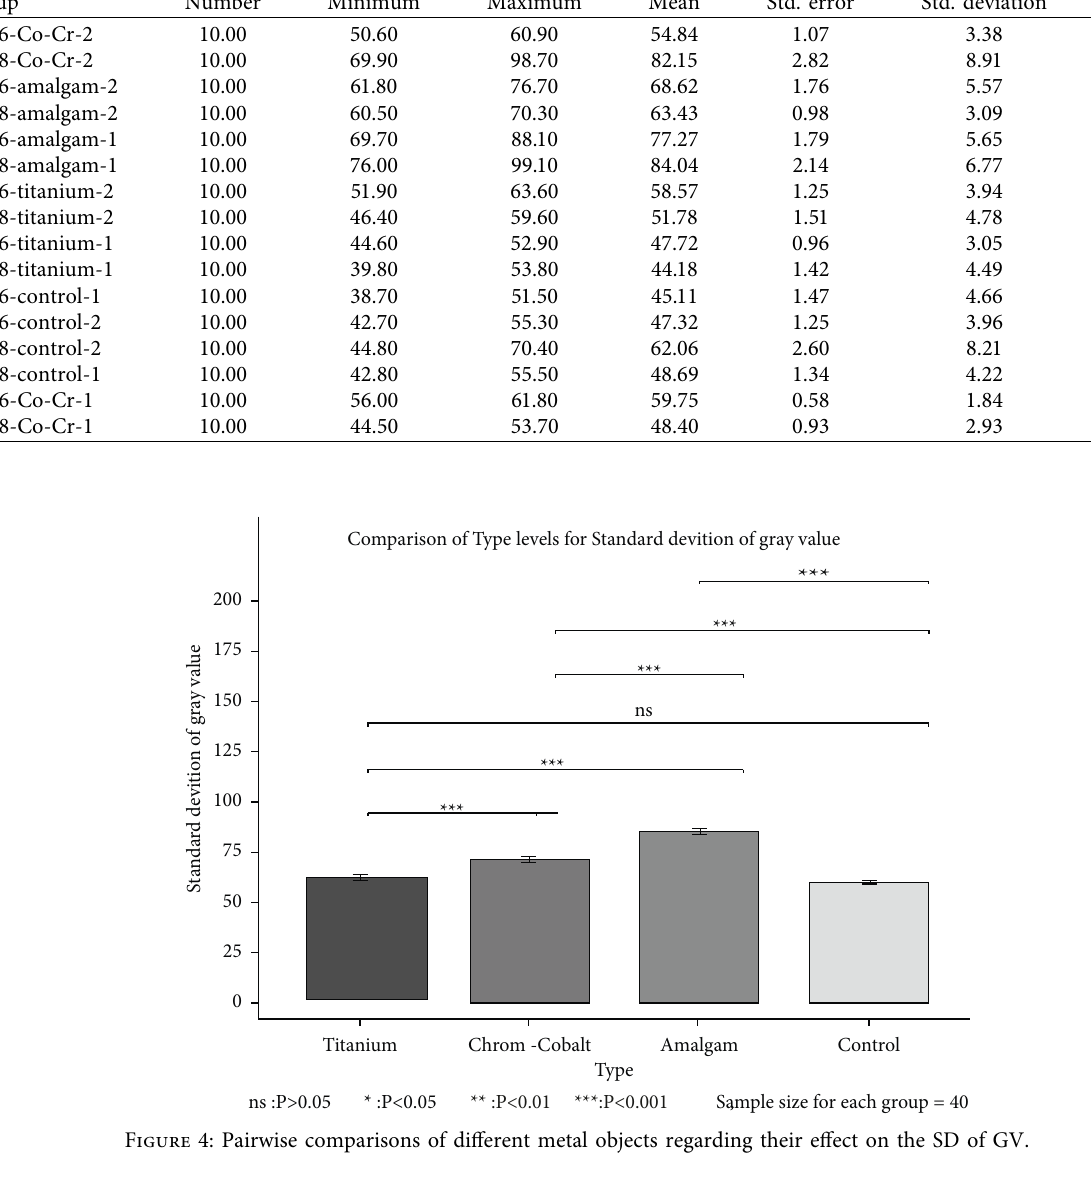
Table 2: Descriptive findings regarding the SD of GV based on the size of FOV and the type and number of metal objects. Group